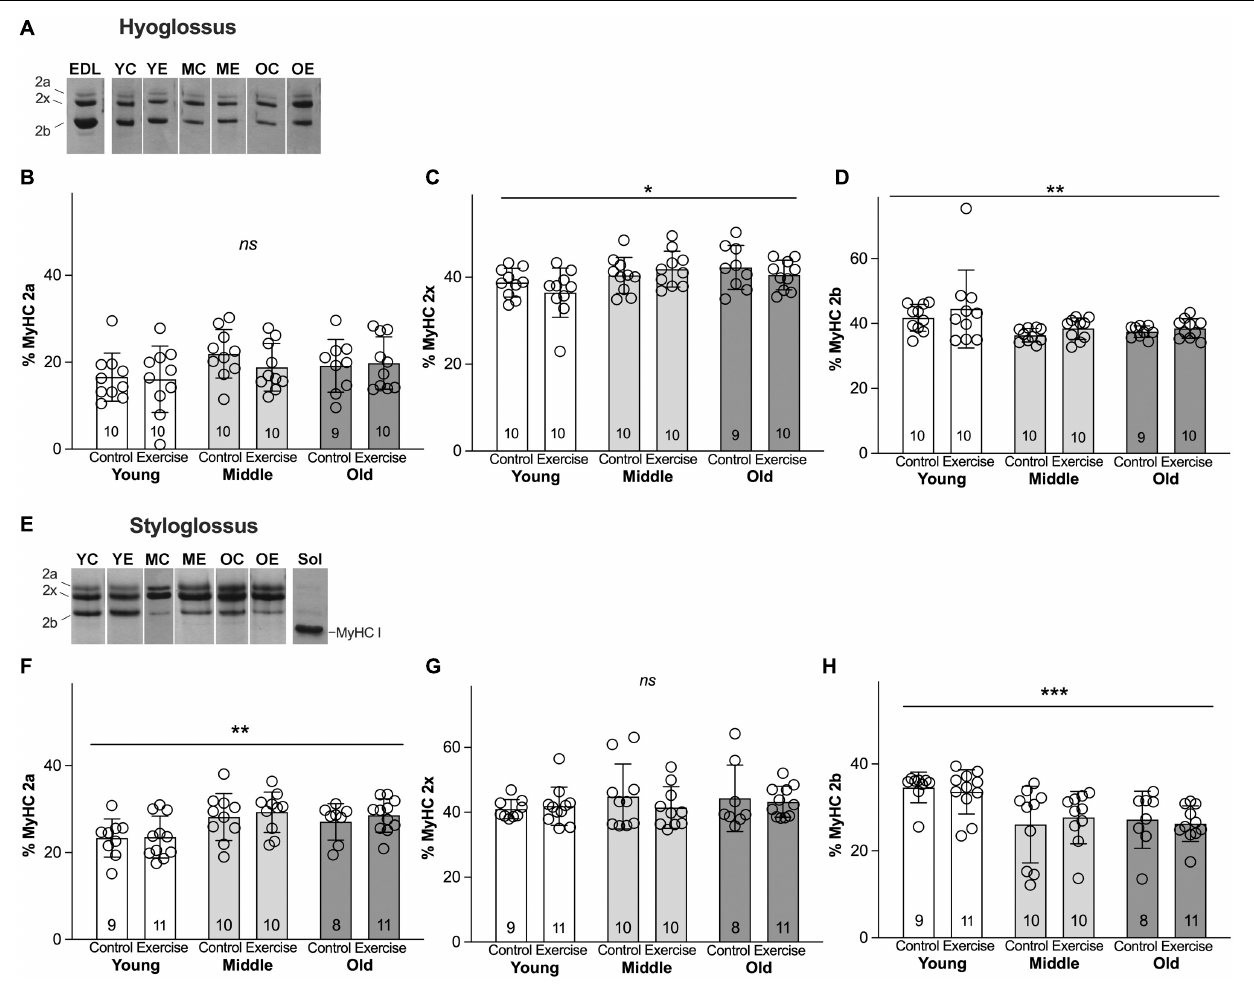
FIGURE 3 | Myosin heavy chain (MyHC) isoform profiles of retrusive tongue muscles change with age, but not with exercise. (A) Representative silver-stained hyoglossus (HG) MyHC gel samples. (B) HG MyHC 2a. (C) HG MyHC 2x. (D) HG MyHC 2b. (E) Representative silver-stained styloglossus (SG) MyHC gel samples. (F) SG MyHC 2a. (G) SG MyHC 2x. (H) SG MyHC 2b. Sol = Soleus muscle control sample, demonstrating relative mobility of the MyHC I isoform. EDL = Extensor digitorum longus muscle control sample, demonstrating relative mobility of the MyHC isoforms. YC = young control, YE = young exercise, MC = middle control, ME = middle exercise, OC = old control, OE = old exercise. Bars indicate mean and SD. Each symbol indicates data for one rat. Group sizes are indicated in bar graphs. *** = P < 0.001, ** = P < 0.01, * = P < 0.05, ns = no significant